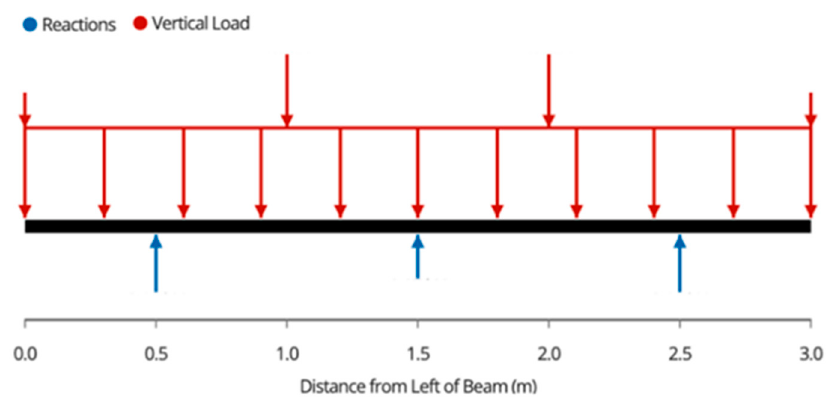
Figure A9. Beam free body diagram for variable angle rack.